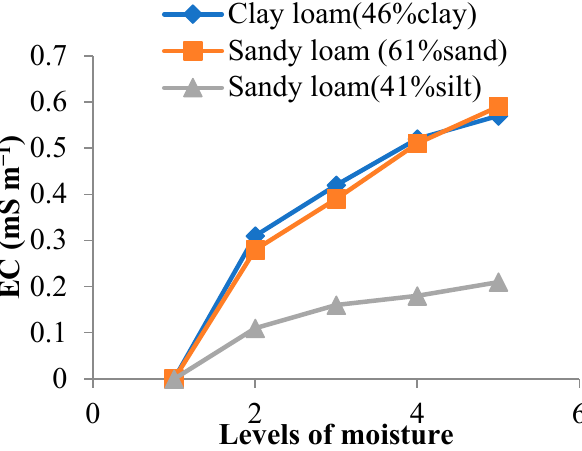
Figure 1. Relation between moisture and EC for different soil samples. For clay loam, the increase in EC was 83.87% when moisture was increased from 13 to 22%. Likewise, the same difference in EC was observed as moisture level was increased for both sandy loam with higher silt and sandy loam with higher sand; their corresponding EC increases were 91% and 111%, respectively. Therefore, moisture level significantly influenced the EC of all three soils.